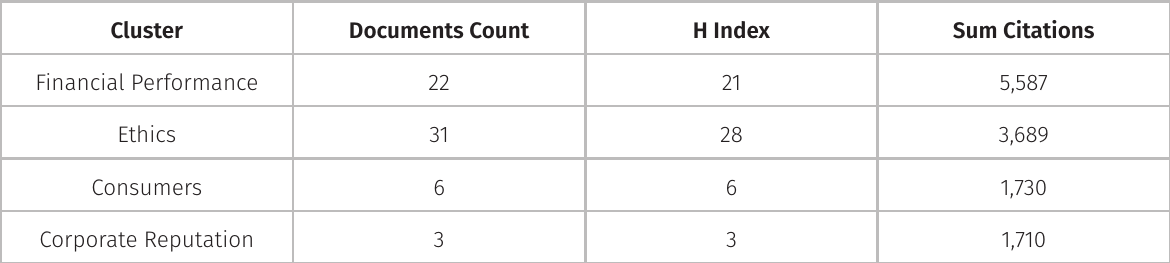
Table V. Performance of the themes in the 1978–2006 period.